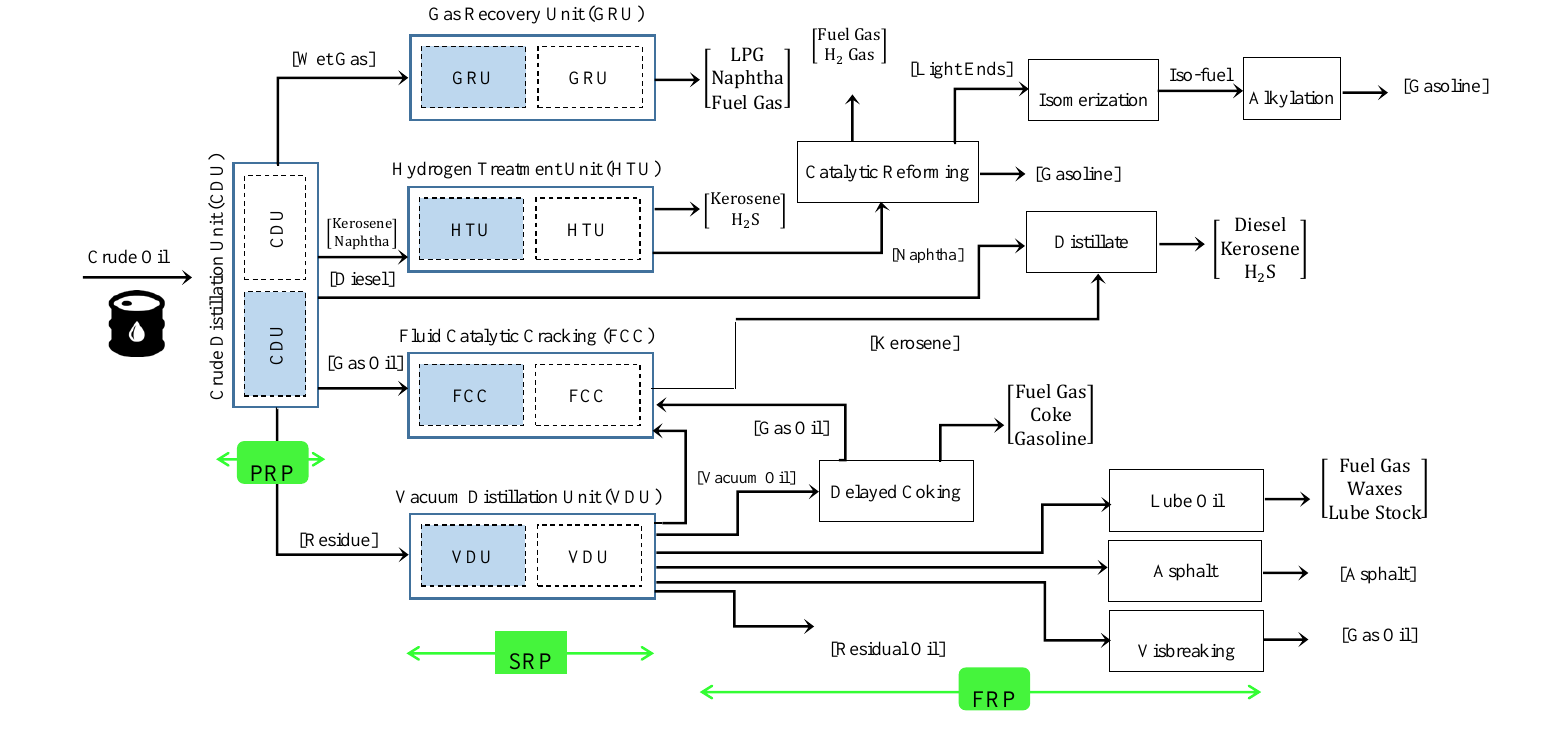
Figure 2. Industrial subprocesses of a modern ORI.